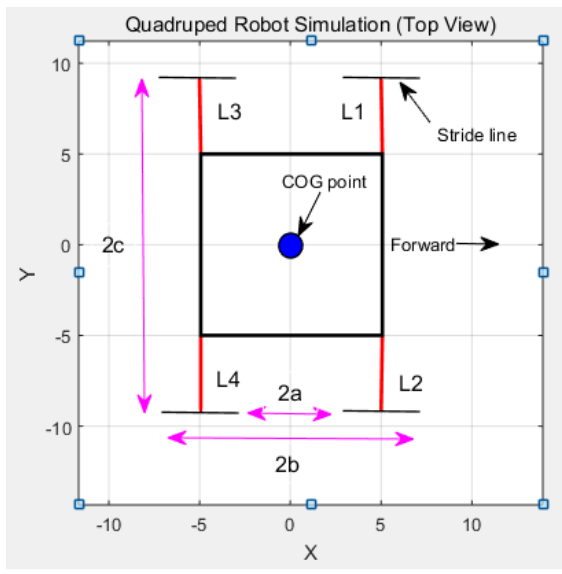
Fig. 1. Quadruped robot (top view) illustrate the length (2b) and the width (2c) and the COG point